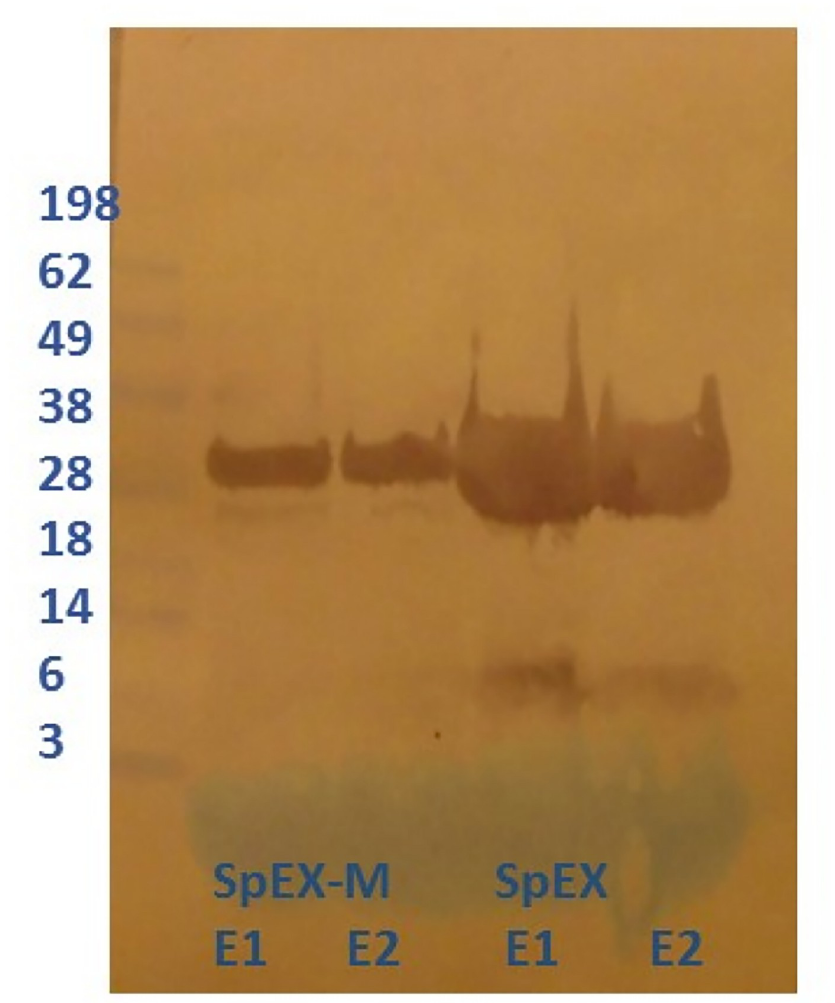
Fig 4. Western blot of recombinant S . pseudintermedius native and mutant SpEX detected with HRP-conjugated anti-6xhis. The Molecular weights of recombinant SpEX (rSpEX) and rSpEX-M, after expression in Tuner (DE3) pLacI E . coli induced by Isopropyl β -D-1-thiogalatopyranoside (IPTG), determined in western blots were of the expected sizes (27. 63 and 27.49 kDa, respectively) in the elution fractions (E1 and E2).